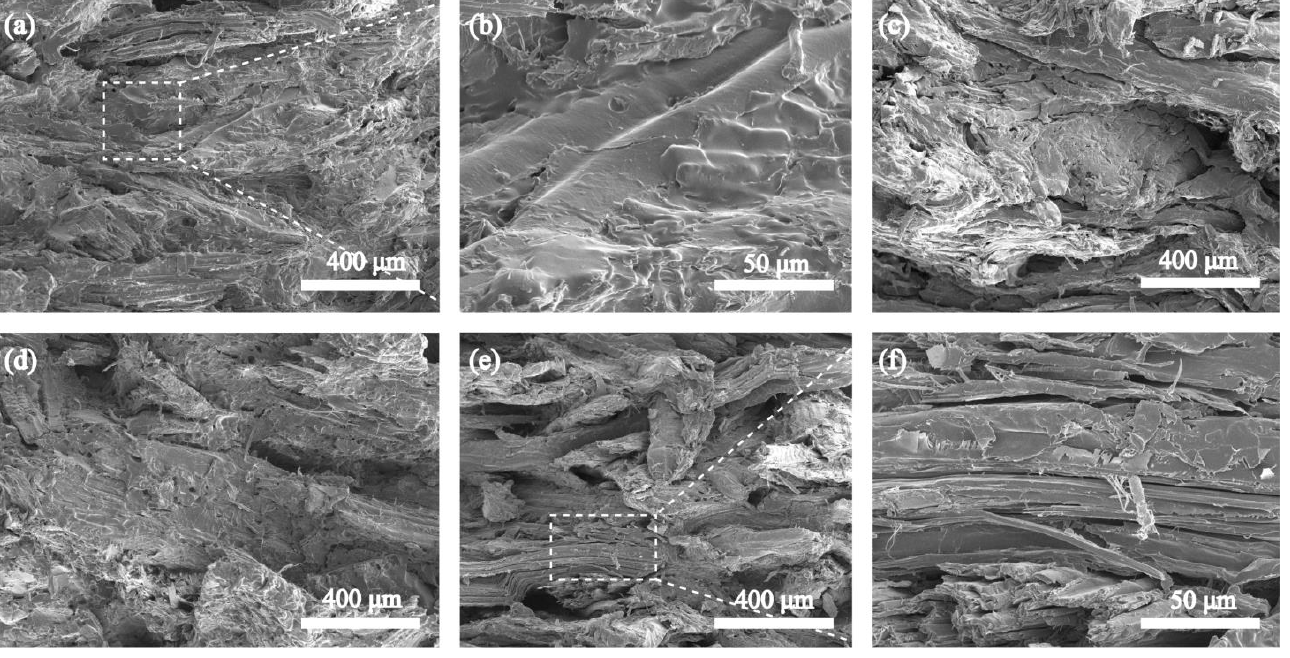
Figure 6. The SEM images of UWPU-60 ( a , b ), UWPU-70 ( c ), UWPU-80 ( d ), and UWPU-90 ( e , f ).